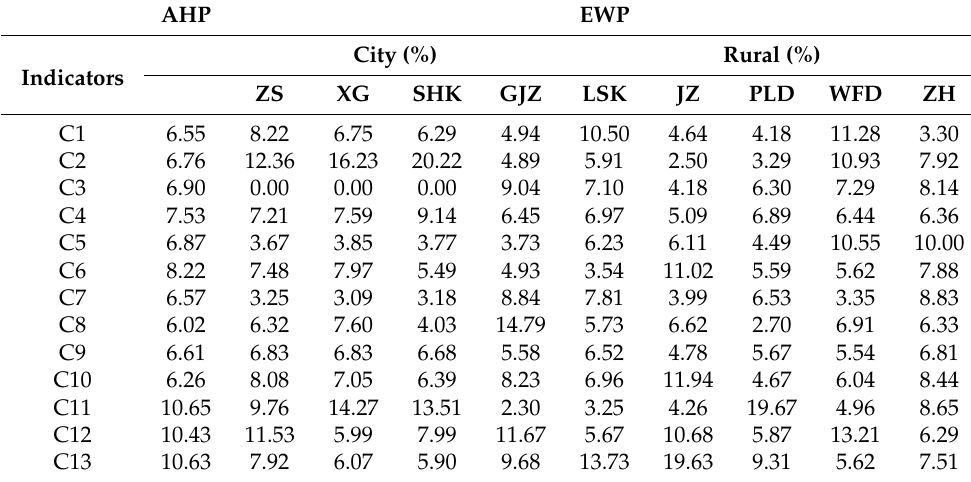
Table 2. AHP and EWP values in urban and rural areas.